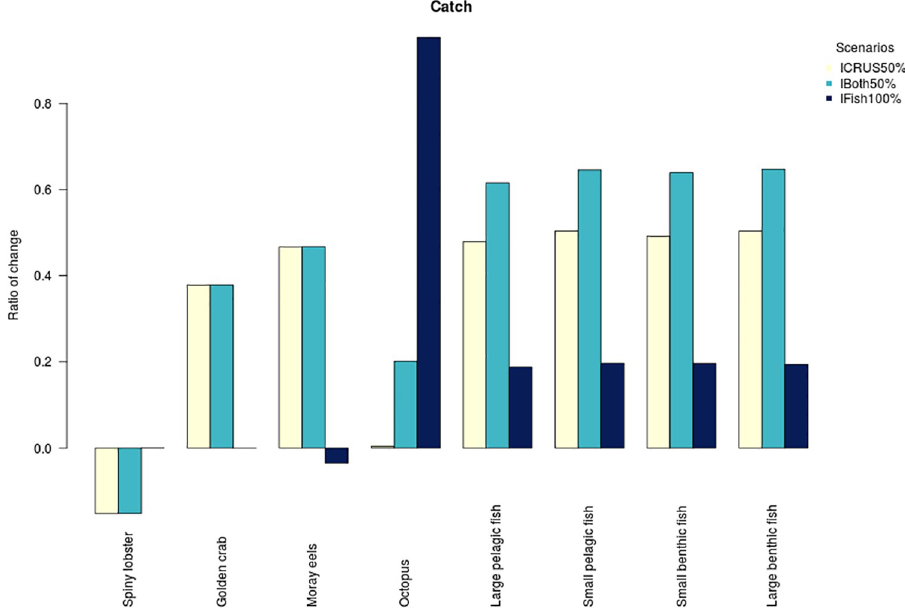
Fig 8. Relative change in catch for the last 20 years of projection for 50% increase in fishing effort of crustaceans (ICRUS50%), a 50% increase in fishing effort for crustaceans and finfish (IBoth50%) and 100% increase in fishing effort for finfish (IFish100%). The catches from a business as usual scenario is the base case for comparisons. Note that the y-axes is the ratio of change against the starting conditions—so a -0.5 result indicates a 50% decrease and a 0.5 result indicates a 50% increase